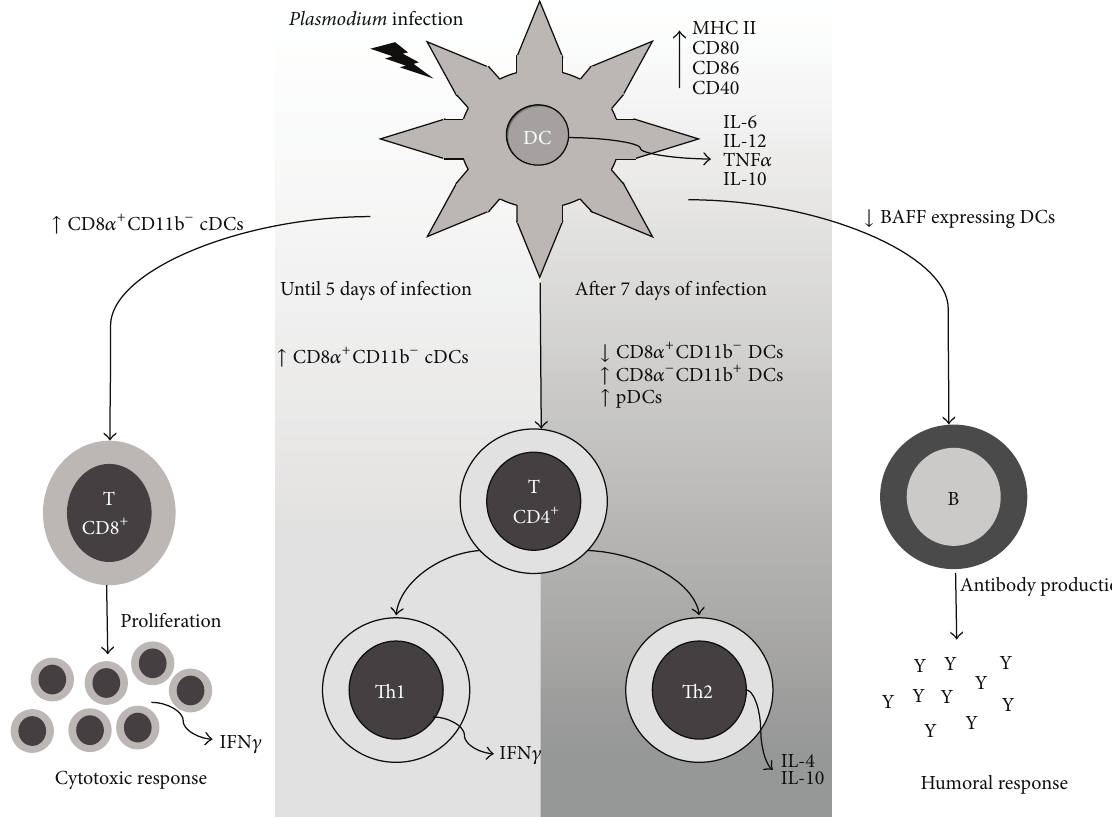
Figure 2: Plasmodium infection activates different DCs subsets. Infection with different stages of Plasmodium activates DCs that in turn start producing proinflammatory (IL-6, IL-12, and TNF 𝛼 ) but also regulatory (IL-10) cytokines. The CD8 𝛼 + CD11b − DCs are responsible for priming CD8 + T cell responses against intrahepatic forms, while both cDCs subsets (CD8 𝛼 + CD11b − and CD8 𝛼 + CD11b + ) play a role in the activation of CD4 + T cell responses that can lead to an inflammatory or regulatory outcome, depending on the timing of infection. pDCs also play a role in the induction of a more regulatory CD4 + T cell response. The number of BAFF expressing DCs is reduced during Plasmodium infection, and that may reduce their ability to support B cell differentiation directly. Based on [69, 70, 78–80, 82, 85, 86,